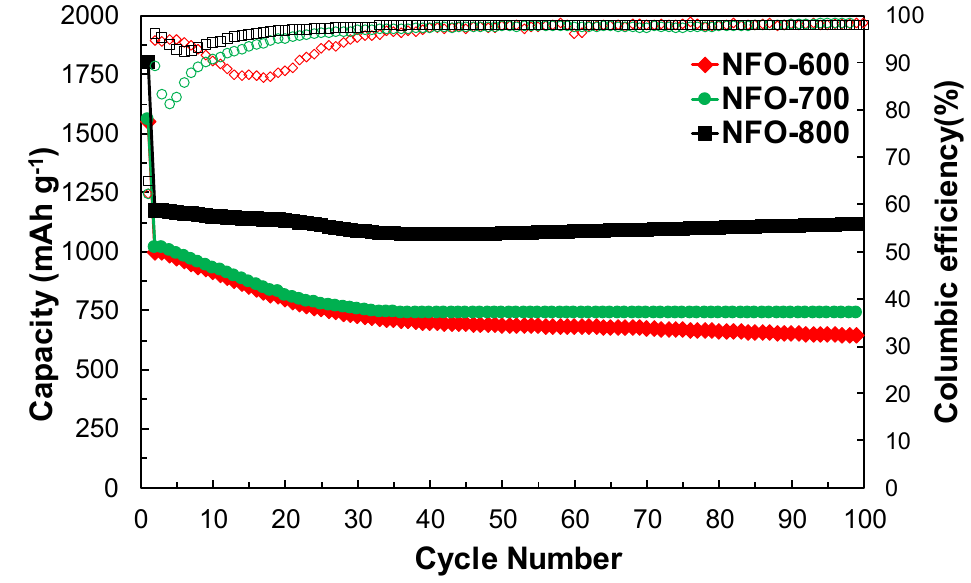
Figure 9. Cycle performance of the NiFe 2 O 4 electrode annealed at different temperatures.